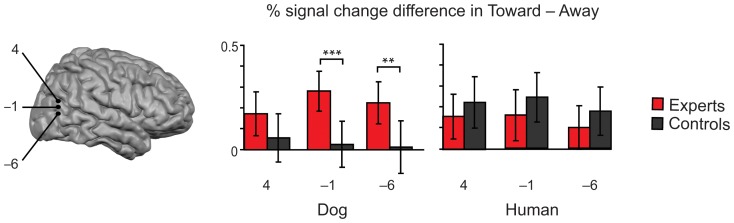
Difference between experts and control subjects in distinguishing body postures of dogs.Left: The locations of the three ROIs vertically adjacent to each other overlaid on the cortical surface. Right: Experts had stronger differences between Dog_toward – Dog_away conditions than control subjects at the two most ventral ROIs of right hemisphere (z = −1 and z = −6). There were no group differences in the signal change between Human_toward – Human_away conditions. ** p = 0.01, *** p<0.001.